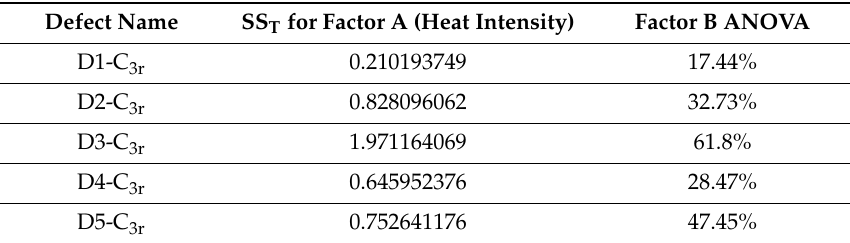
Table 7. Factor A ANOVA for C100 \ Q1.